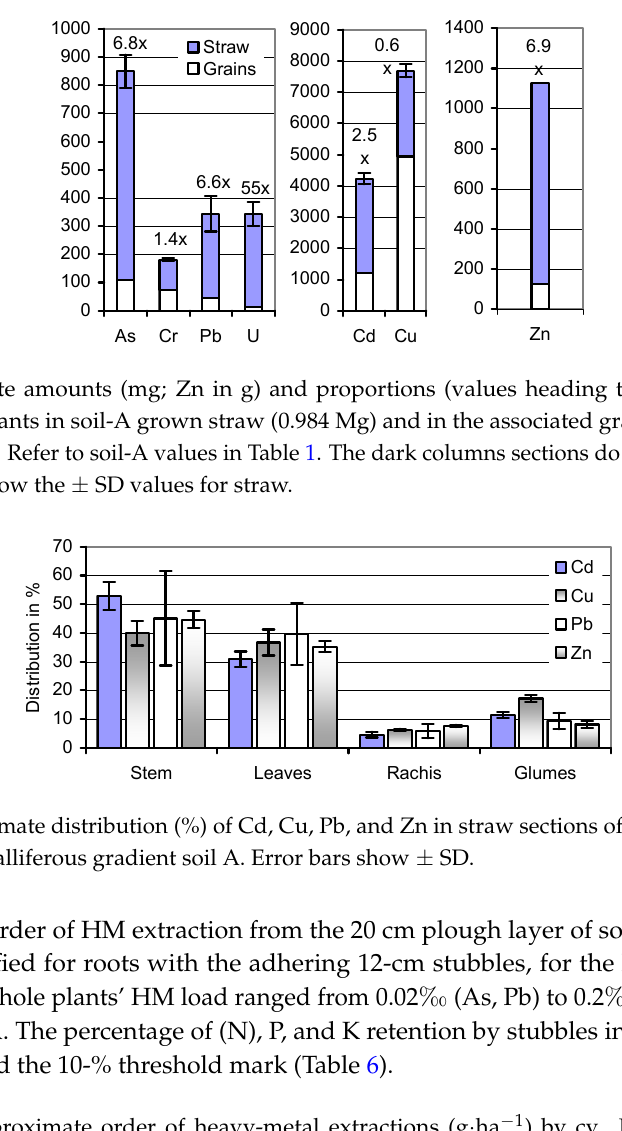
Table 5. The approximate order of heavy-metal extractions (g ∙ ha − 1 ) by cv. JB Asano and their proportions (‰) to the total content in the 20-cm plough layer of soil A. Compare Table 1 for total soil concentrations.